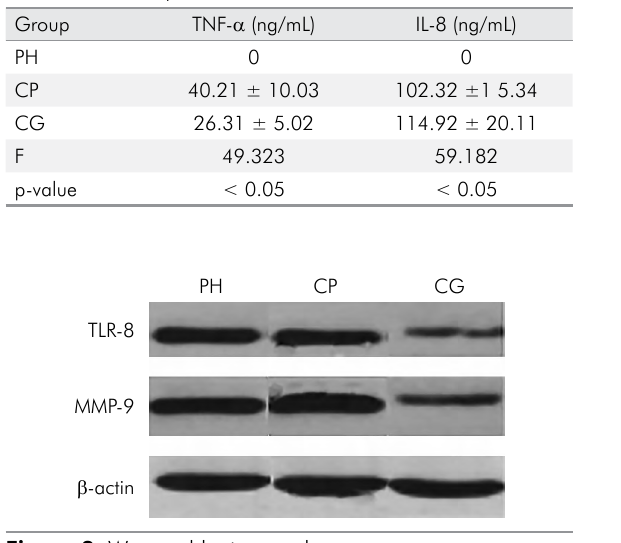
Figure 2. Western blotting results.